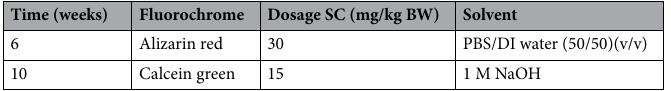
Table 2. Injection schedule and dosage of polyfluorochrome